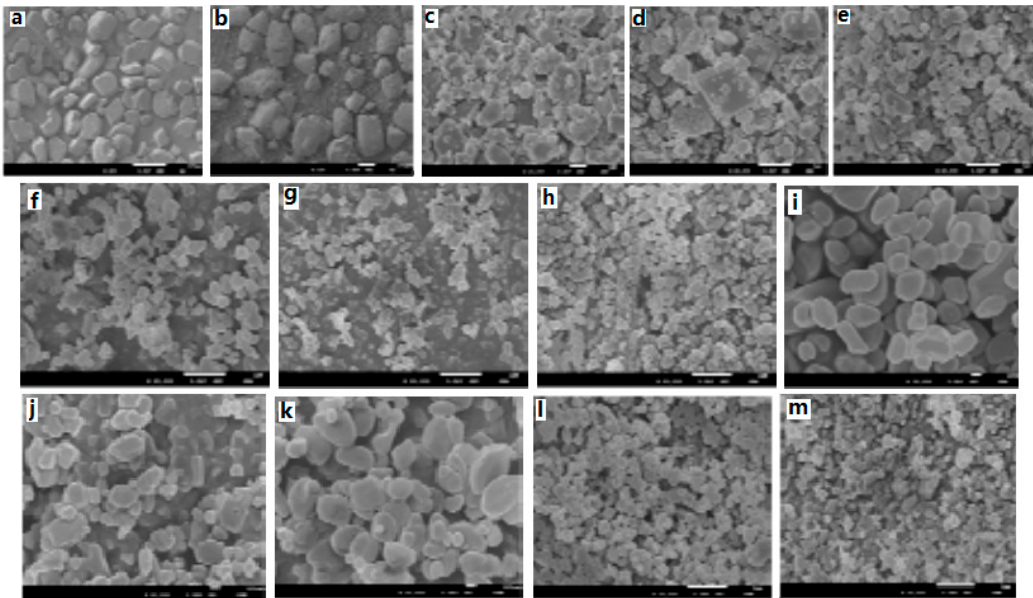
Figure 10. SEM photographs of CL-20/HMX mixture at different milling time. ( a ) 10 min; ( b ) 20 min;